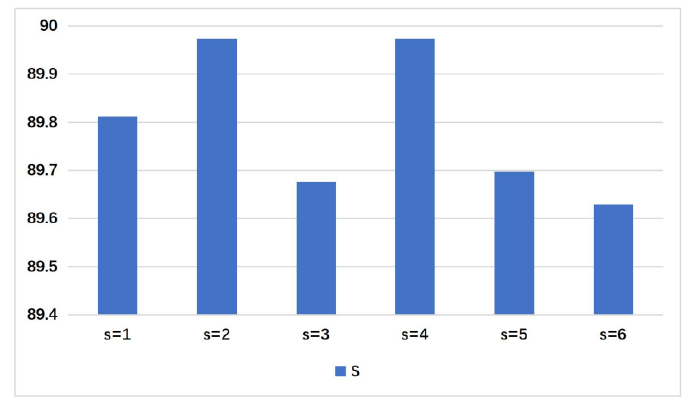
Figure 6. The verification of the impact of different scale 𝒔 on FI dataset.